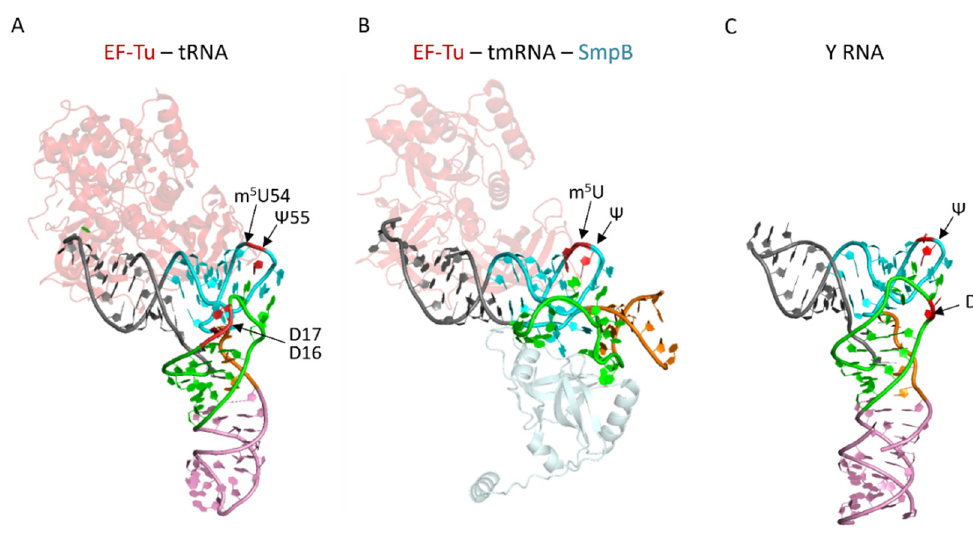
Figure 3. The structures of tmRNA and Y RNA mimic part of the tRNA structure. ( A ) The structure of EF-Tu-tRNA Phe complex (with GDPNP, GTP analog) from Thermus aquaticus (pdb file 1TTT [189]). Each domain of the tRNA is colored: acceptor am in grey, TY-arm in light blue, the variable region in orange, the D-arm in green, and the anticodon-arm in pink. EF-Tu structure is represented in light pink. ( B ) The structure of the tmRNA fragment in complex with EF-Tu (with GDP and kirromycin antibiotic, in light pink) and SmpB (in light grey) from Thermus thermophilus (pdb file 4V8Q [190]). The regions of tmRNA mimicking tRNA are shown with the same color code as for the tRNA. ( C ) Salmonella Typhimurium Y RNA (YrlA, pdb file 6CU1 [191]). The regions of YrlA mimicking tRNA are shown with the same color code as for the tRNA.